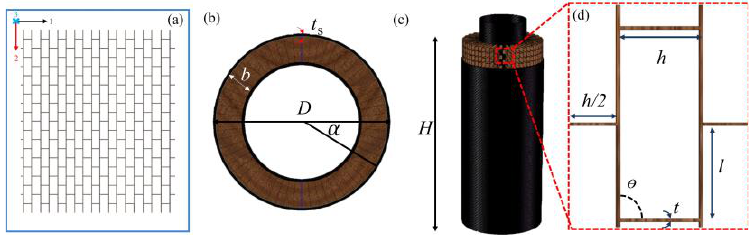
Figure 3d. The length of the circumferential arc is h , the length of vertical ribs is l , the reentrant angle is θ , and the thickness of the unit wall is t .